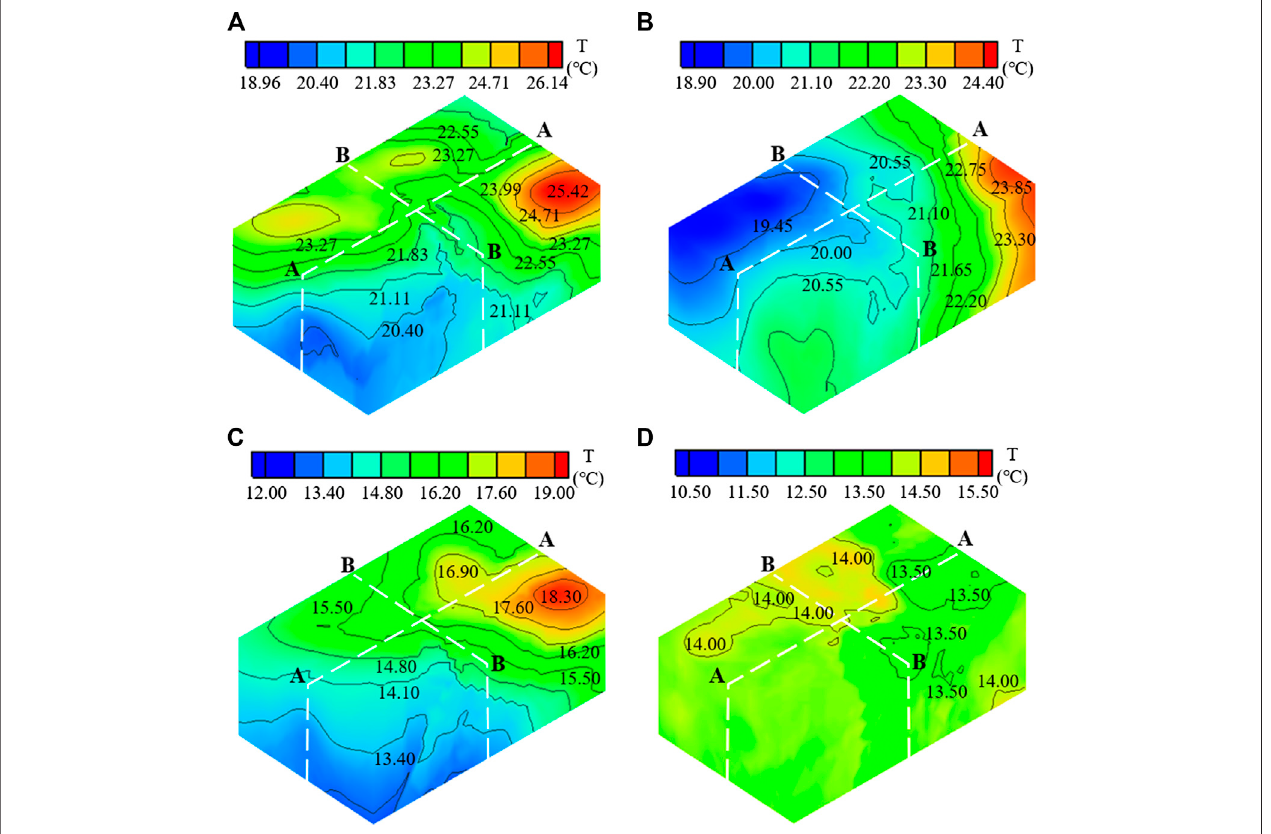
FIGURE 12 | The 3D thermal field in the concrete blocks 12#-0033, 0034, 0035 and 0036: (A) May 1, 2019; (B) Aug 1, 2019; (C) Nov 1, 2019; (D) Jan 1, 2020.